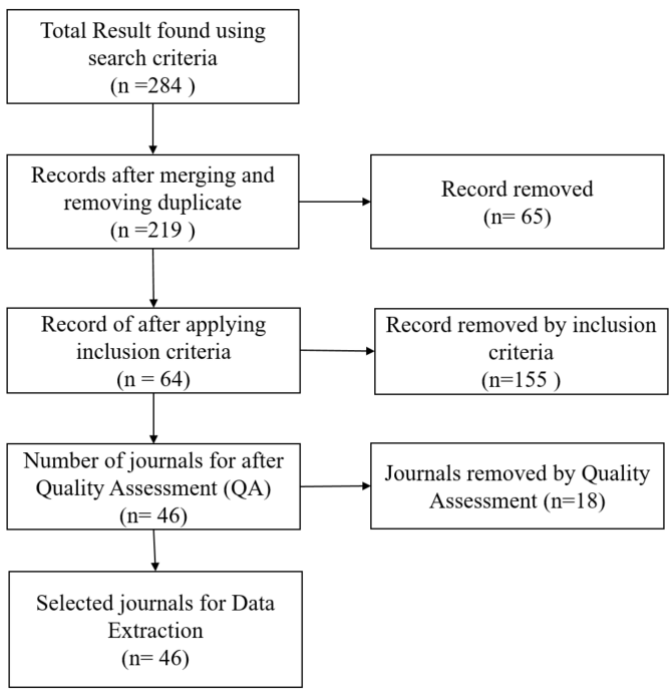
Figure 1. SLR process in this